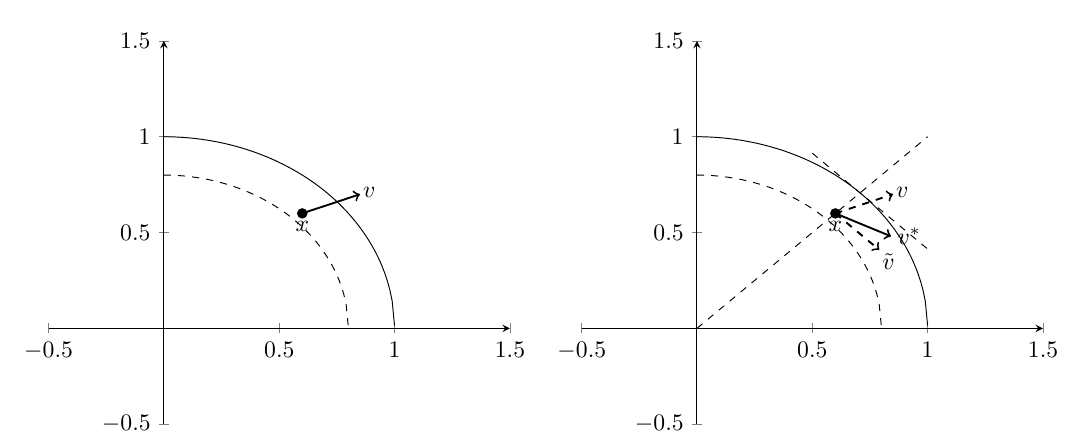
Figure 2: Velocity vector at the